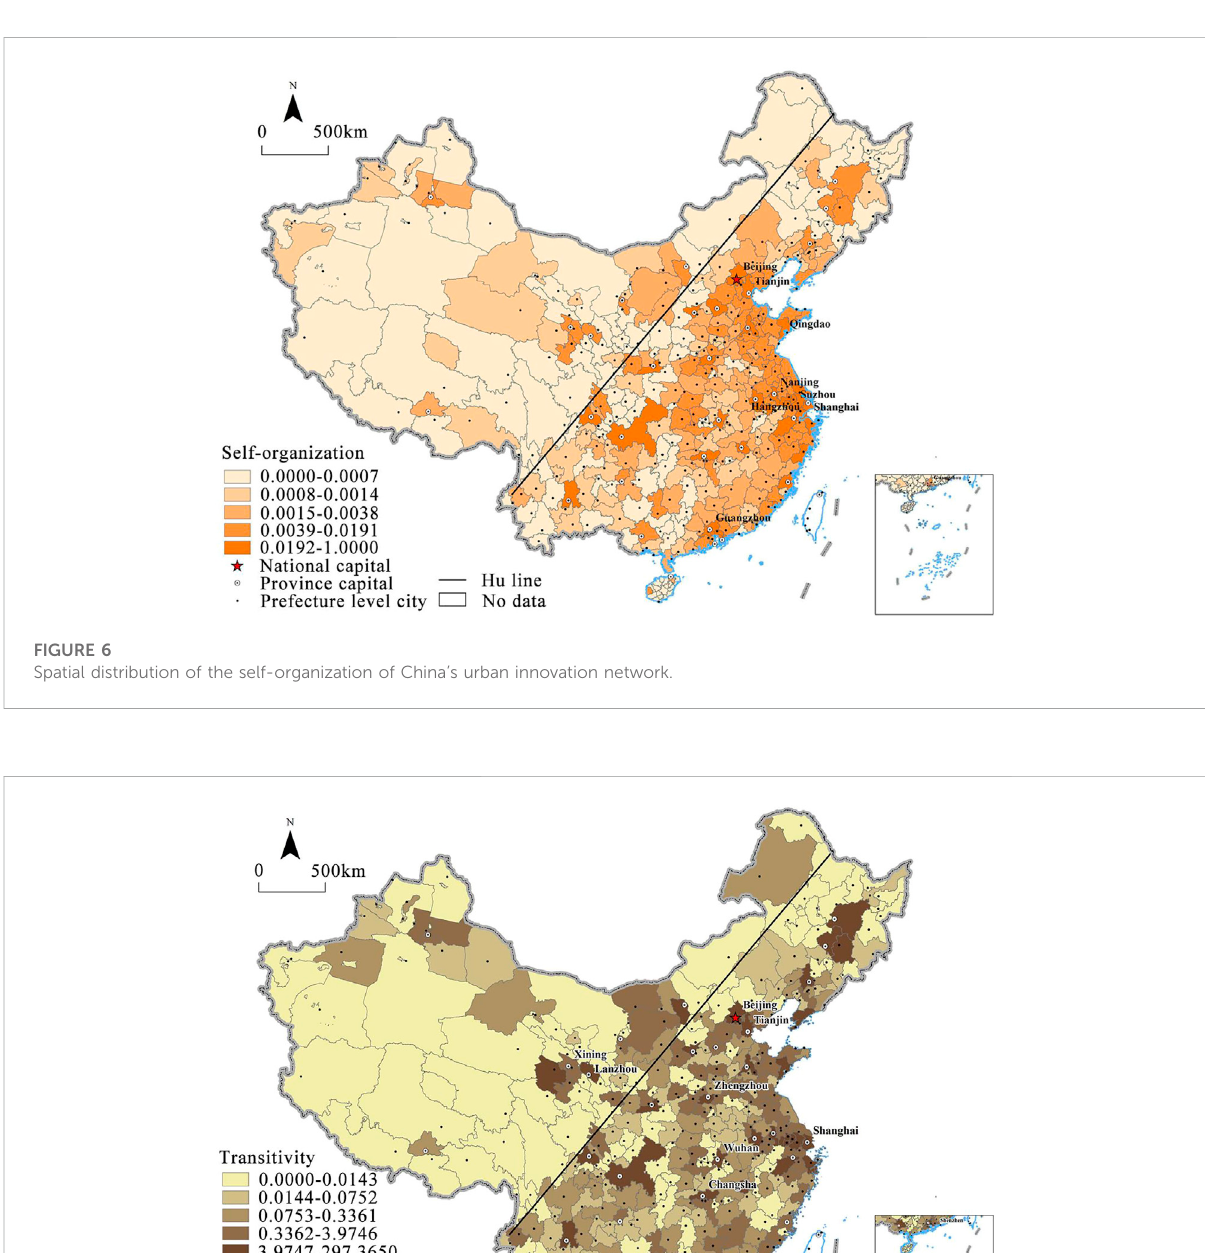
Figure 5 displays the degree correlation, respectively, in 2017, 2018, and 2019. Speci fi cally, the absolute values of the coef fi cient in 3 years are 0.3176, 0.2619, and 0.2454. The decreasing trend indicates that the network disassortativity is weakening year by year, as the assortative relationships are